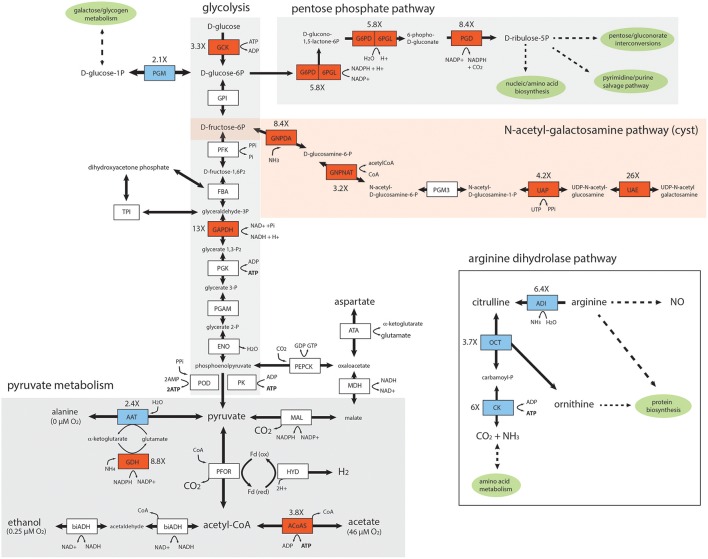
Key enzymes in the glycolytic, pentose phosphate, pyruvate, and UDP-N-acetyl-galactosamine pathways are upregulated in the in vivo Giardia foci. Diagrammatic representation of differentially expressed enzymes associated with in vivo Giardia energy and biosynthetic pathways. Red shading denotes increased expression of in vivo relative to in vitro transcripts, and blue shading denotes decreased expression. White shading indicates no significant differential expression between in vivo foci and in vitro (TYDK) transcriptomes. Oxygen concentrations associated with different branches of the pyruvate metabolic pathway are noted (Lindmark, 1980). The enzyme abbreviations, names, GiardiaDB (GL50803) ORFIDs, and Enzyme Commission numbers are: Glycolysis: ACYP, acylphosphatase (7871), EC 3.6.1.7; ENO, enolase (11118), EC 4.2.1.11; FBA, fructose-bisphosphate aldolase (11043), EC 4.1.2.13; GAPDH, glyceraldehyde-3-phosphate dehydrogenase (17043), EC 1.2.1.12; GPI, glucose-6-phosphate isomerase (9115), EC 5.3.1.9; GCK, glucokinase (8826), EC 2.7.1.2; PFK, phosphofructokinase (14993), EC 2.7.1.90; PGAM, phosphoglycerate mutase (8822), EC 5.4.2.1; PGK, phosphoglycerate kinase (90872), EC 2.7.2.3; PGM, phosphoglucomutase (17254), EC 5.4.2.2; PK, pyruvate kinase (17143,3206),EC 2.7.1.40; POD, pyruvate:orthophosphate dikinase (9909), EC 2.7.9.1; TPI, triose phosphate isomerase (93938), EC 5.3.1.1. Pyruvate metabolism: ATA, aspartate transaminase (91056), EC 2.6.1.1; FeADH, Fe-alcohol dehydrogenase (3861, 3593) EC 1.1.1.1; ACoAS, acetyl-CoA synthetase (13608); AAT, alanine aminotransferase (12150, 16353), EC 2.6.1.2; biADH (bifunctional alcohol/aldehyde dehydrogenase E (93358), EC 1.1.1.1; GDH, NADP-specific glutamate dehydrogenase (21942) EC 1.4.1.3, 1.4.1.4; Fd, ferredoxin (9662, 27266,10329); HYD, hydrogenase (6304), EC 1.12.7.2; MAL, malic enzyme (14285), EC 1.1.1.38; MDH, malate dehydrogenase (3331), EC 1.1.1.37; PEPCK, phosphoenolpyruvate carboxykinase (10623), EC 4.1.1.32; PFOR, pyruvate:ferredoxin oxidoreductase (17063, 114609); Pentose Phosphate Pathway (PPP): G6PD-6PGL, glucose-6-phosphate-1-dehydrogenase (8682), EC 1.1.1.49; PGD, phosphogluconate dehydrogenase (14759), EC 1.1.1.44; UDP-N-acetylgalactosamine (GalNac) biosynthetic pathway: GNPDA, glucosamine-6-phosphate deaminase (8245), EC 3.5.99.6; GNPNAT, glucosamine 6-phosphate N-acetyltransferase (14651), EC 2.3.1.4; PGM3, phosphoacetylglucosamine mutase (16069), EC 5.4.2.10; UAE, UDP-N-acetylglucosamine 4-epimerase (7982), EC 5.1.3.2; UAP, UDP-N-acetylglucosamine diphosphorylase (16217), EC 2.7.7.23. Arginine Dihydrolase Pathway: ADI, arginine deiminase (112103), EC 3.5.3.6; ARG-S, arginyl-tRNA synthetase (10521), EC 6.1.1.19; CK, carbamate kinase (16453), EC 2.7.2.2; NOS, nitric oxide synthase (91252), EC 1.14.13.39; OCD, ornithine cyclodeaminase (2452), EC 4.3.1.12; OCT, ornithine carbamoyltransferase (10311), EC 2.1.3.3; ODC, ornithine decarboxylase (94582), EC4.1.1.17; PRO-S, prolyl-tRNAsynthetase (15983), EC 6.1.1.15.